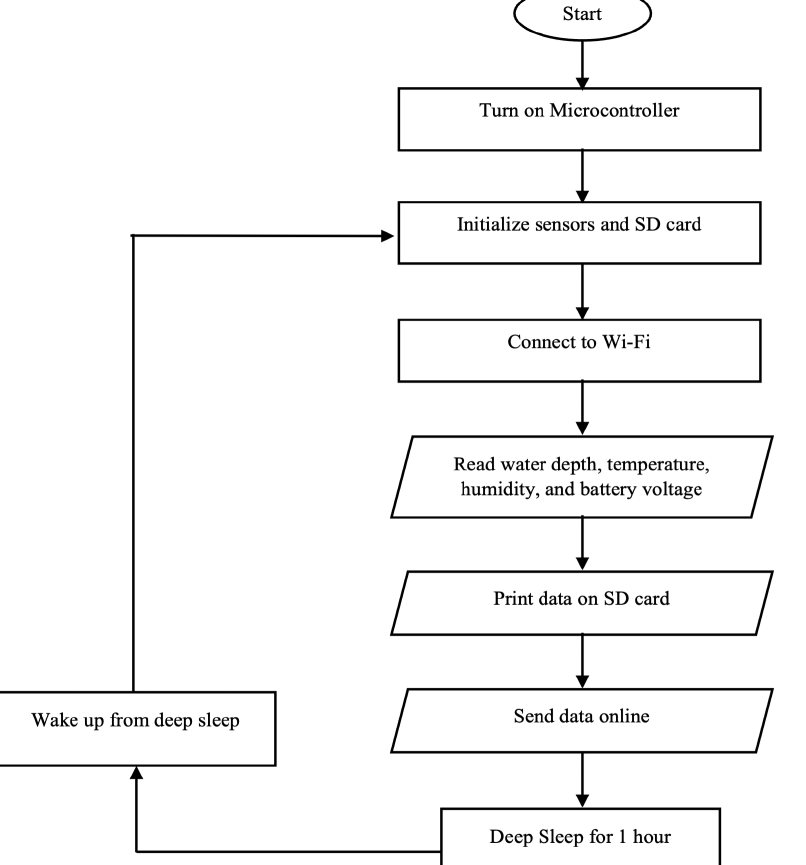
Figure 3. Algorithm of the low-cost wireless sensor operation.